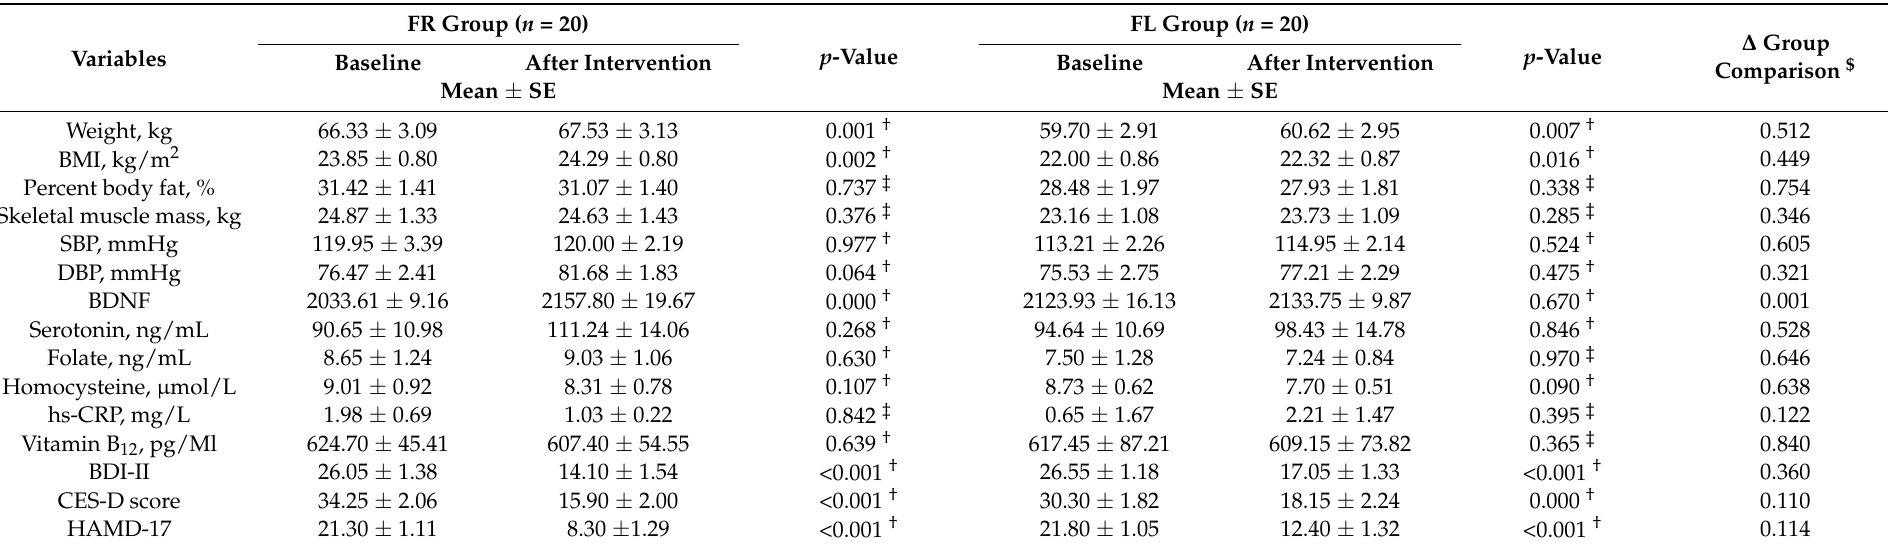
Table 2. Anthropometric data and blood test and MDD screening results at baseline and 8 weeks after